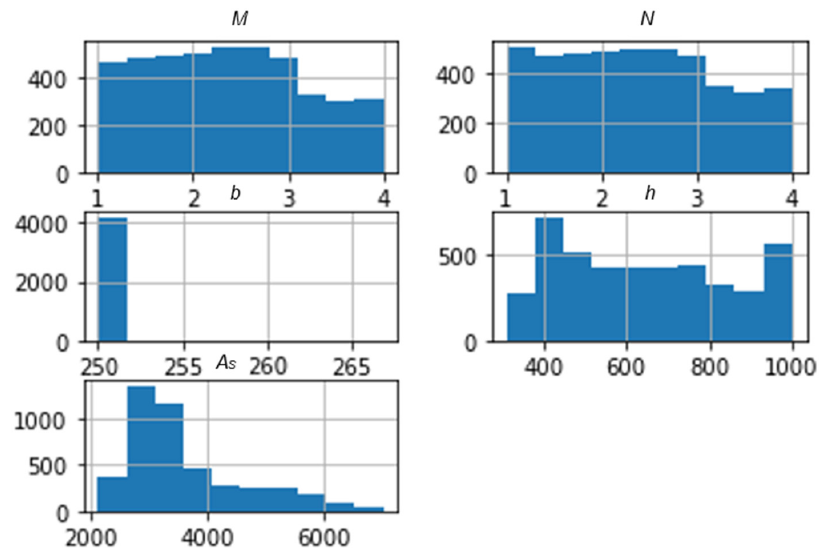
Figure 3. The histogram plots of the